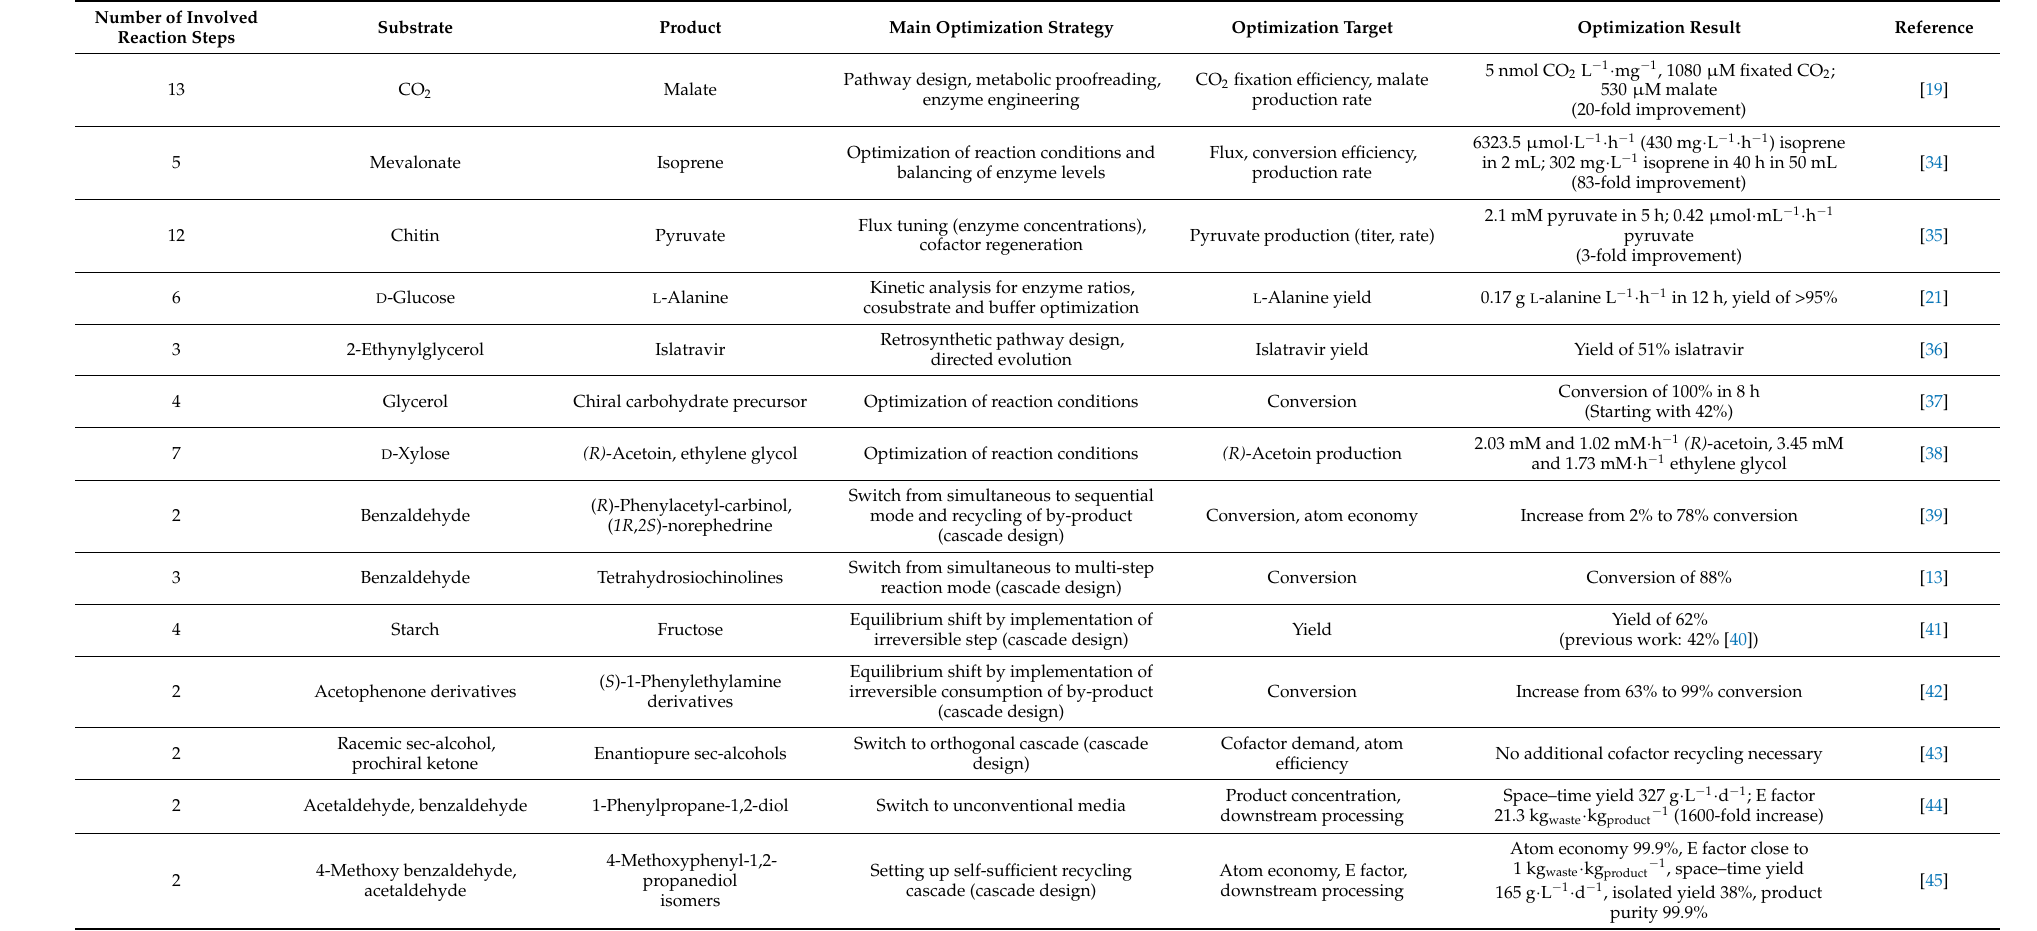
Table 1. Experimental based approaches for enzyme cascade